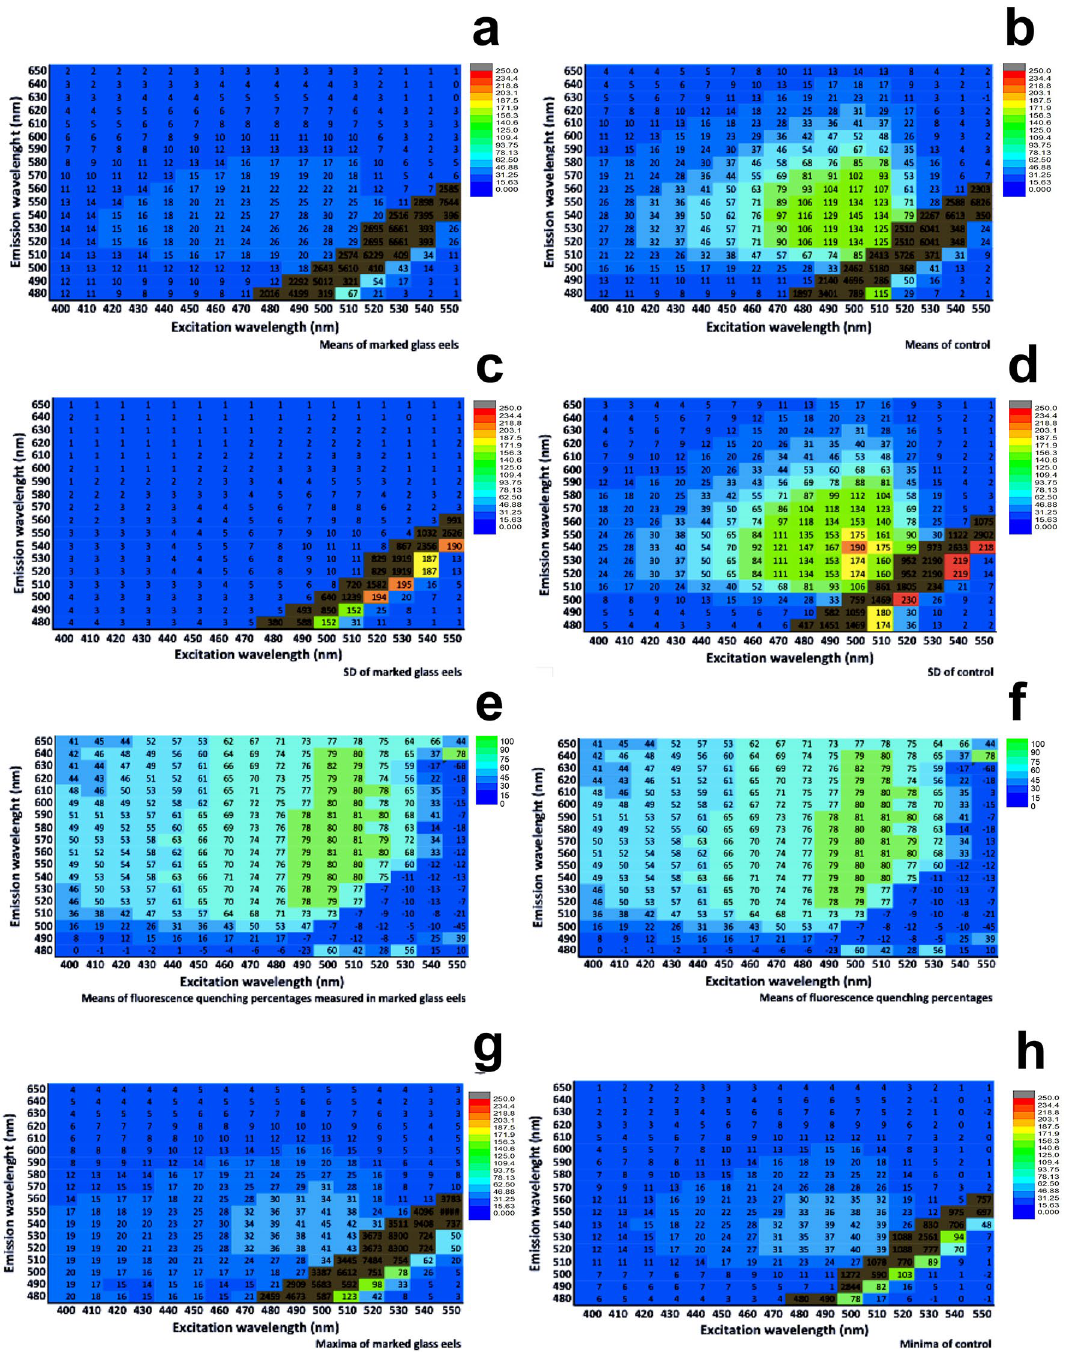
Figure 4. Excitation-Emission Matrix (EEM) spectra of glass eels in the alizarin peak. EEM of fluorescence intensities means of ( a ) marked and ( b ) control glass eels; EEM of fluorescence intensities standard deviations of ( c ) marked and ( d ) control glass eels; EEM of ( e ) means and ( f ) standard deviations of the fluorescence quenching percentage measured in the marked group; EEM of the fluorescence intensities ( g ) maximum of the marked glass eels and ( h ) minimum of the control glass eels. Fluorescence intensities are in arbitrary units (a. u.) and presented for each excitation-emission wavelength (numbers in the cells). n = 12 in each